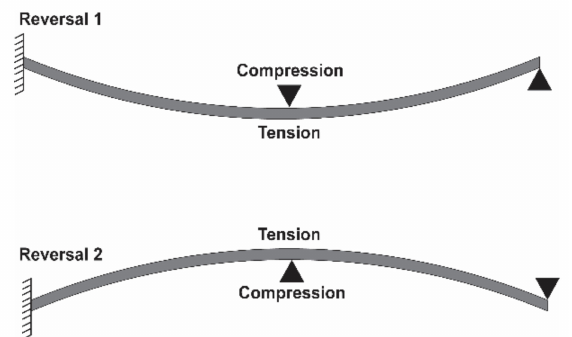
Figure 4. Example of a bending load. When a bending load is applied, the object experiences both tensile and compressive forces. During fully reversed cycling, the tensile and compressive forces alternate sides, resulting in the sinusoidal pattern observed in Figure